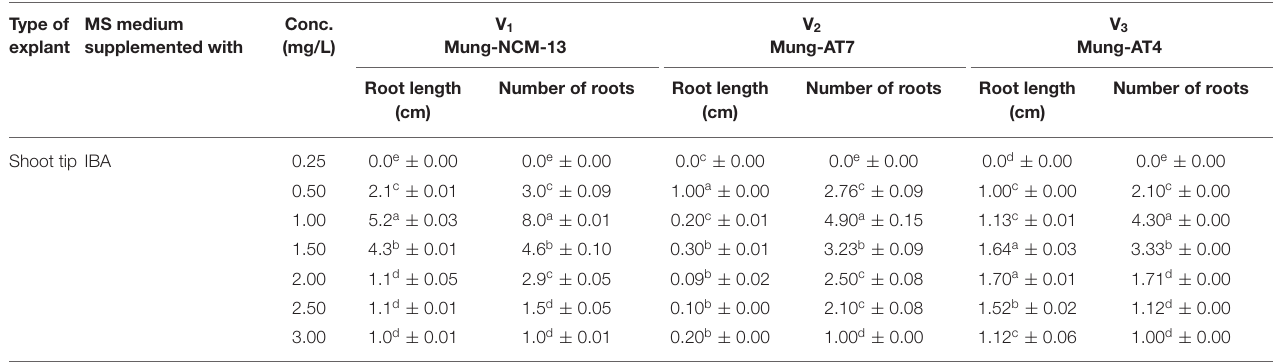
TABLE 2 | Effect of MS + IBA on rooting of in vitro culture establishment of three varieties of Vigna radiate . Type of MS medium explant supplemented